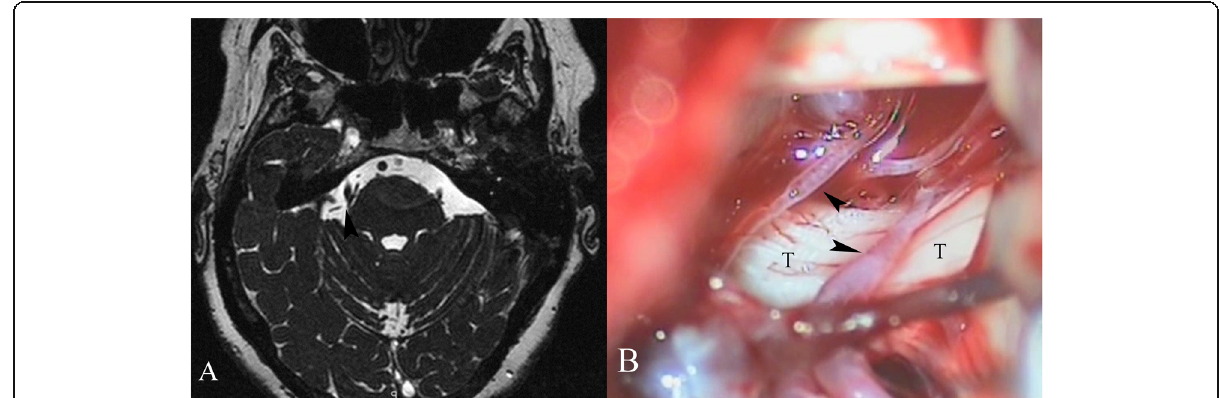
Fig. 1 a FIESTA showing vascular compression at the root of the right trigeminal nerve. b Microscopic view (right side): T., trigeminal nerve, arrowheads point to vascular compression